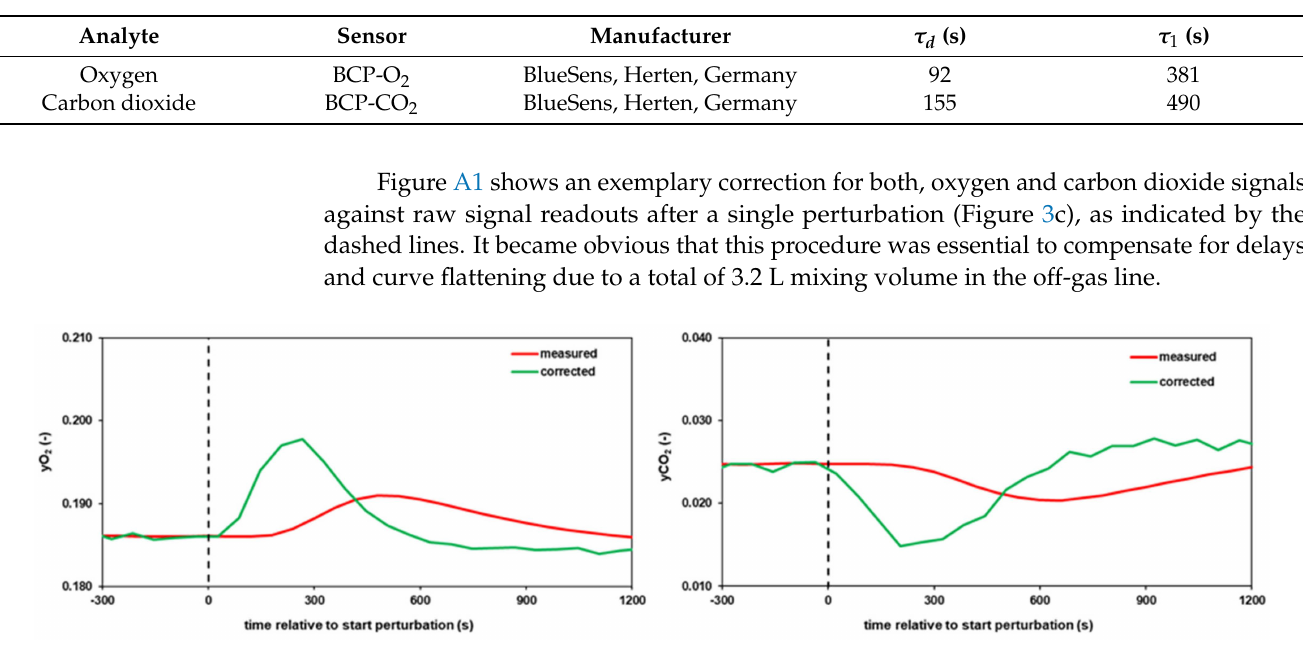
Figure A1. Exemplary deconvolution results for O 2 and CO 2 signals of one replicate after a single perturbation (see Figure 3c). Deconvolution of O 2 (left panel) and CO 2 (right panel) signals (green) was calculated based on equations (A1) and (A2), parameters from Table A1 and plotted against raw signals